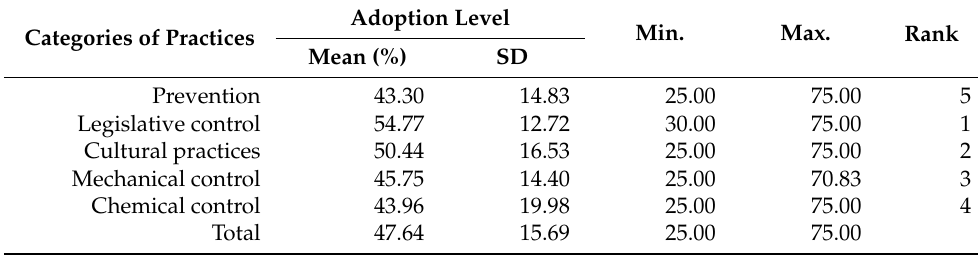
Table 3. Overall adoption of integrated pest management categories for red palm weevil